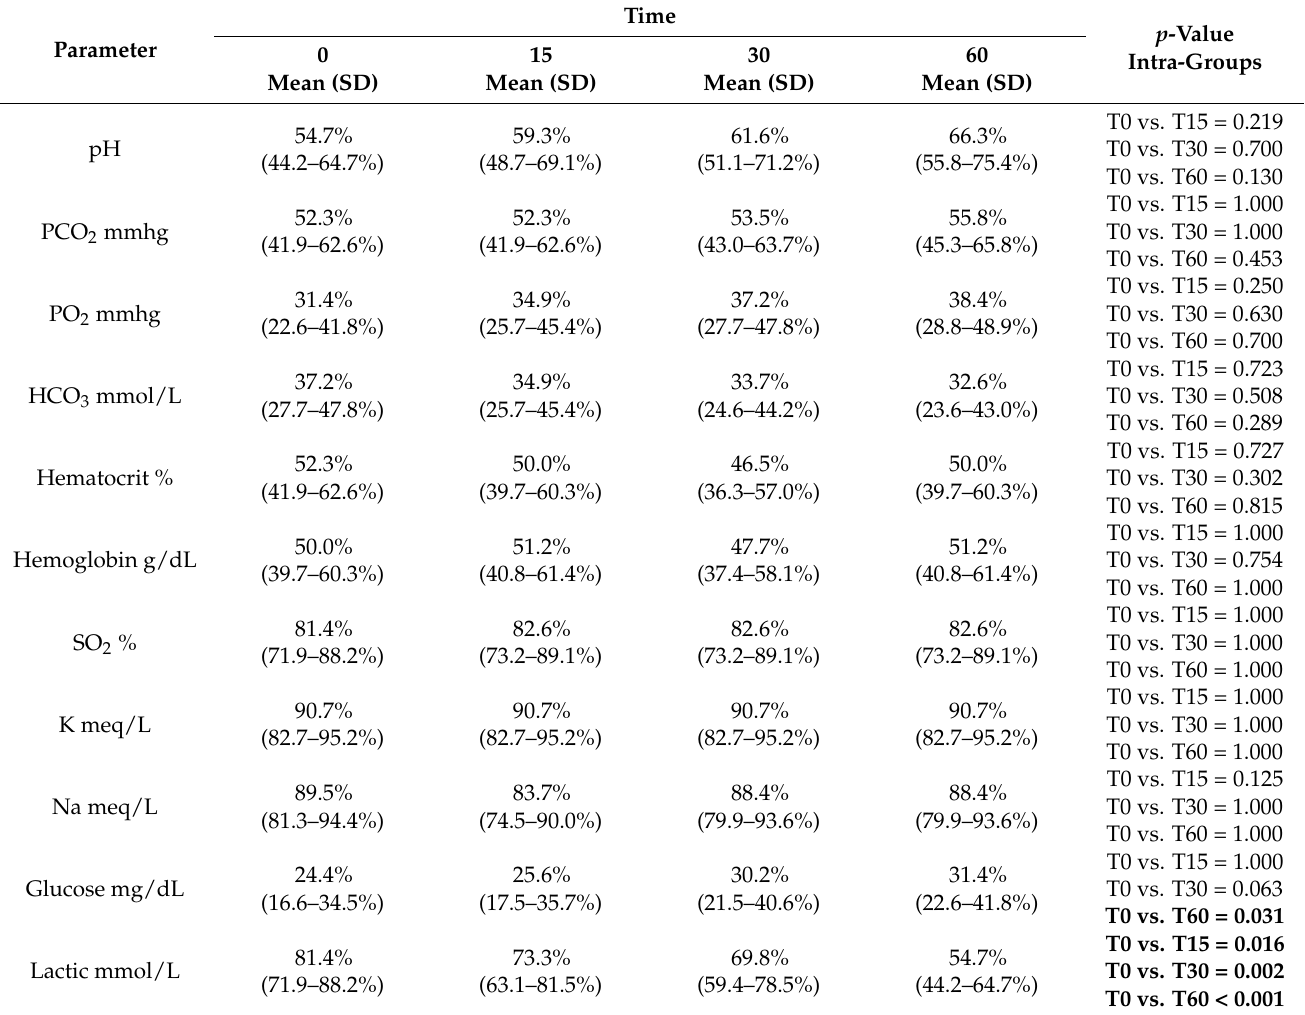
Table 2. Percentage of gasometric samples with normal